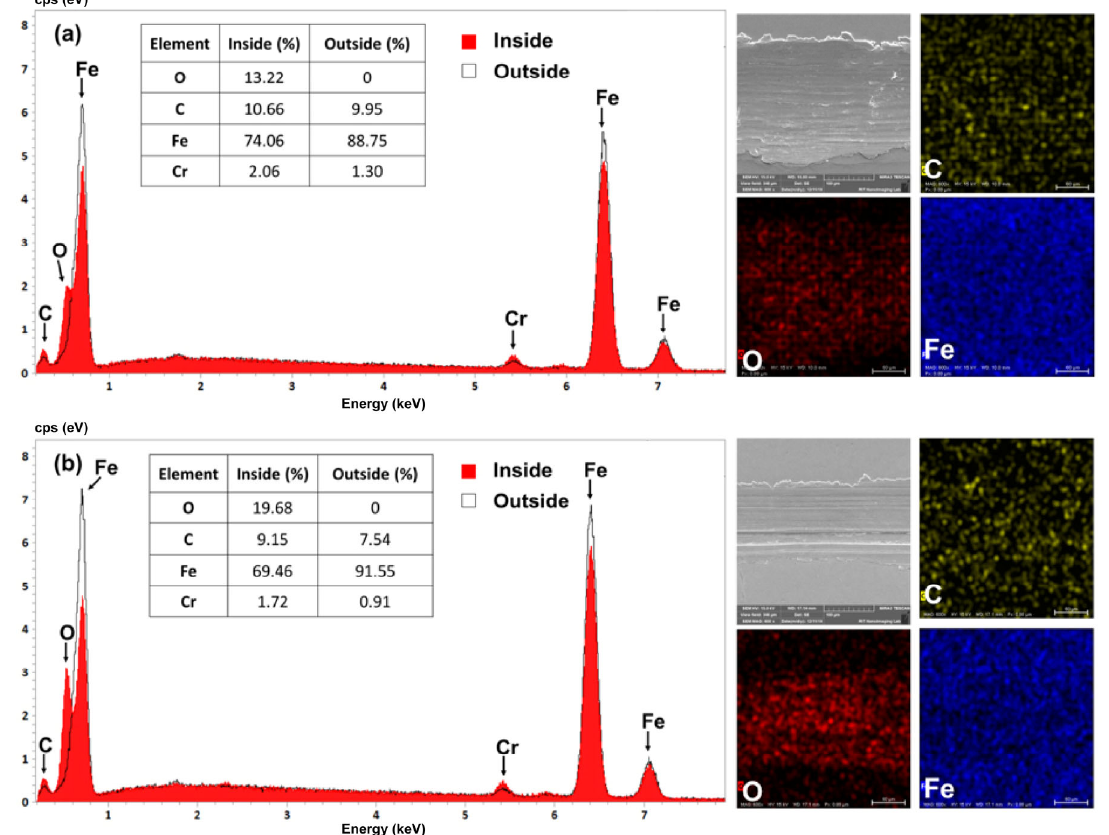
Fig. 13 EDS spectrum inside and outside the wear track and element mapping after lubricated with (a) MO at 100 ºC and (b) 1 wt% DCi+MO at 100